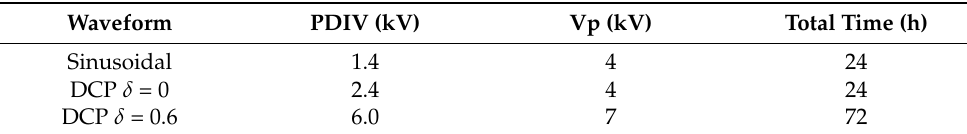
Table 1. Data measurements.